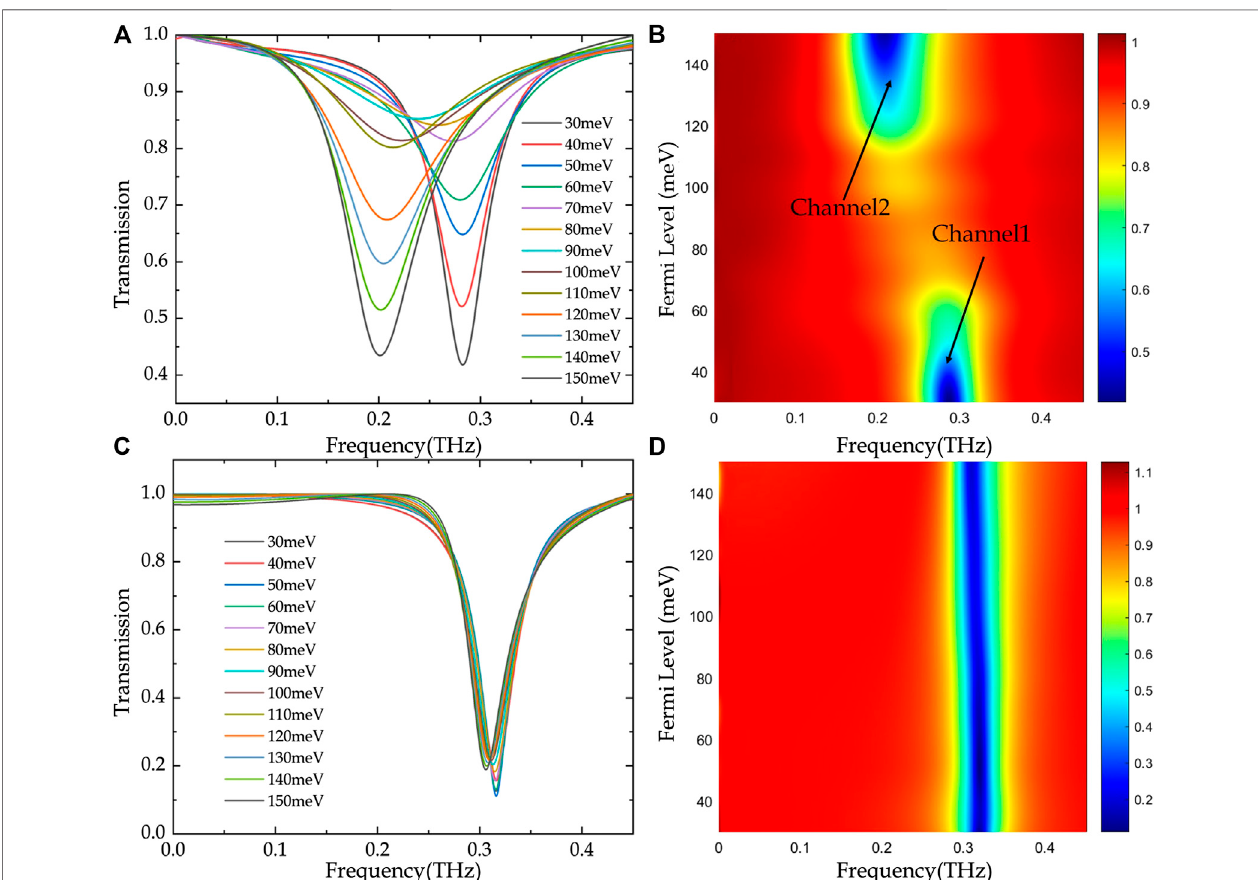
FIGURE 5 | (A, C) Simulated transmission spectra as a function of the Fermi levels of the Dirac semimetal fi lm (DSF) and (B, D) Fermi levels as a function of the frequency and transmission. The thicknesses of the DFS and substrate (polyimide) are set at 30 nm and 50 μ m, respectively. The thicknesses of the dielectric layer are set at (A, B) 5 μ m and (C, D) 24 μ m.